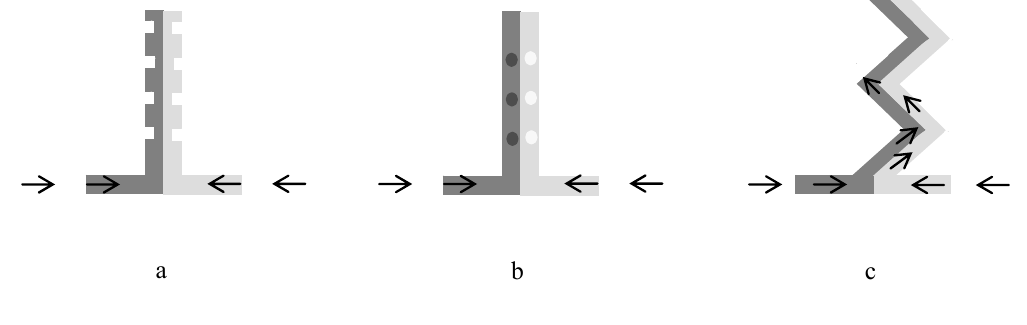
Figure 3. Examples of typical configurations to enhance mixing in microchannels: (a) obstacles on the wall of the microchannel; (b) obstacles in the microchannel (c) zig-zag microchannel. Arrows suggest direction of